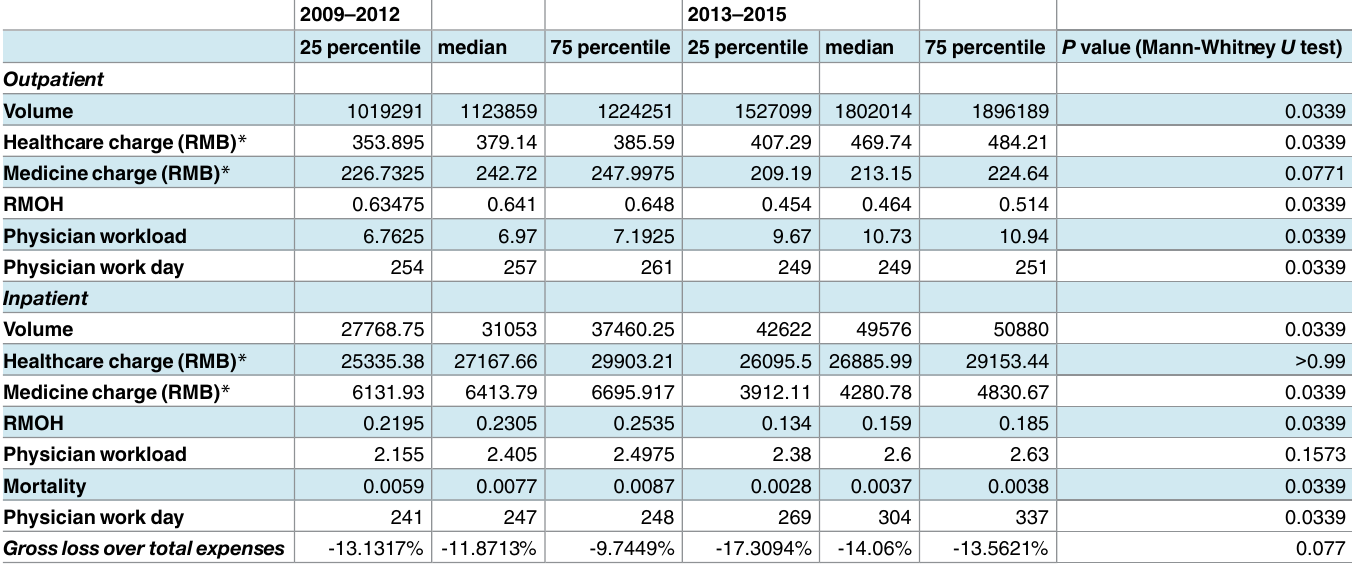
Table 1. Comparison of the effectsassociated withthe drug-price zero-markup policyimplemented in Dec 2012 at the Jishuitanhospitalat Xinjie- kou campus,